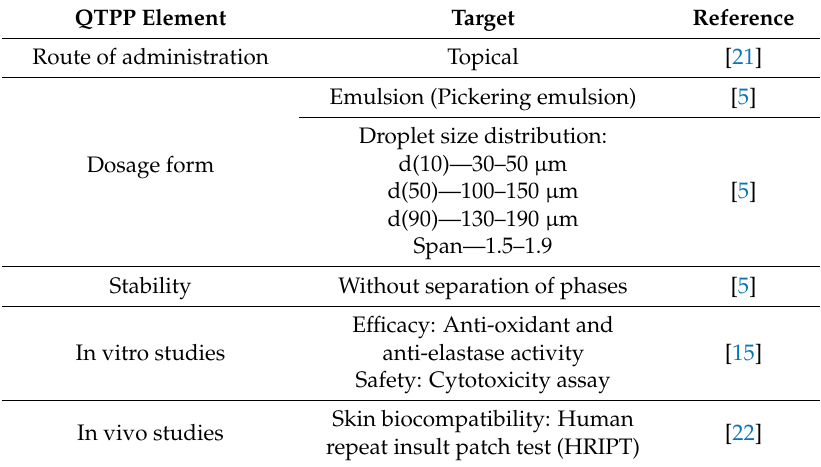
Table 1. QTPP of QSB-stabilized